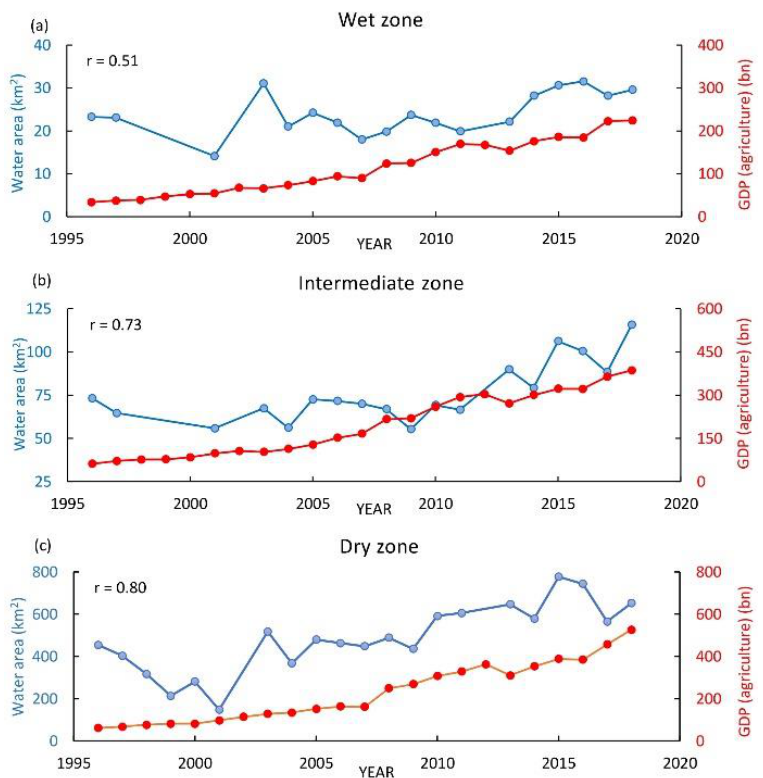
(Figure 12). The Dry zone ( p -value = 1 × 10 −5 , r = 0.80) showed high correlation, followed by Intermediate ( p -value = 6 × 10 −4 , r = 0.73) and Wet ( p -value = 0.03, r = 0.51) zones.